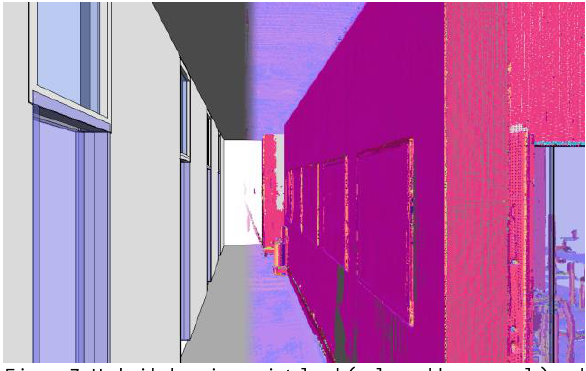
Figure 7. Hybrid showing pointcloud (coloured by normals) and resultant parametric model in a Revit 2014 3D view